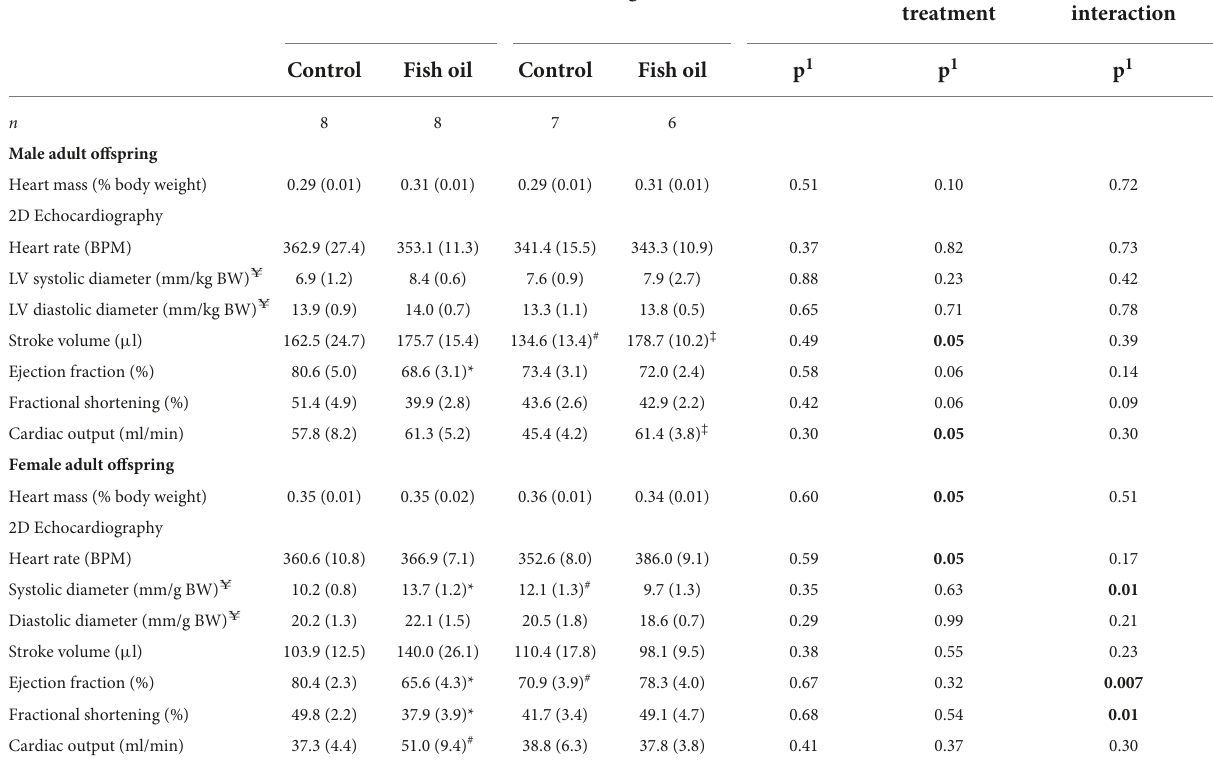
TABLE 9 Heart mass and 2D Echocardiography data of the subgroup of male and female adult offspring according to the maternal diet (control or high-fat diet) and the gel treatment during pregnancy [fish oil or control (no oil gel)]. Maternal control diet Maternal high-fat diet Effect of diet Effect of